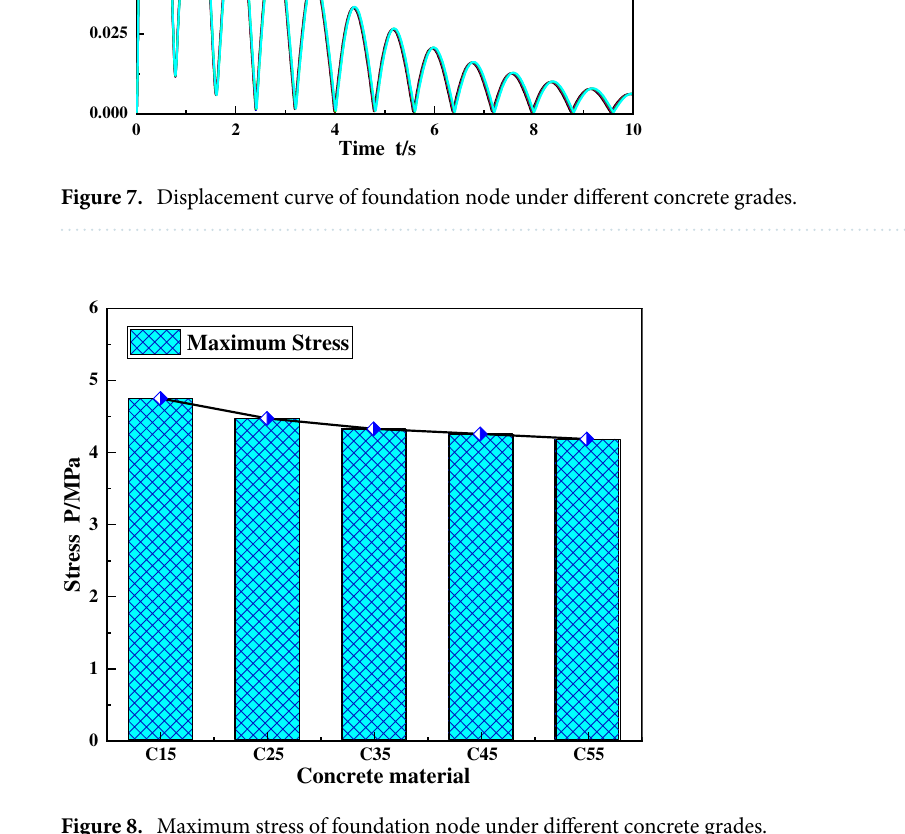
Figure 8. Maximum stress of foundation node under different concrete